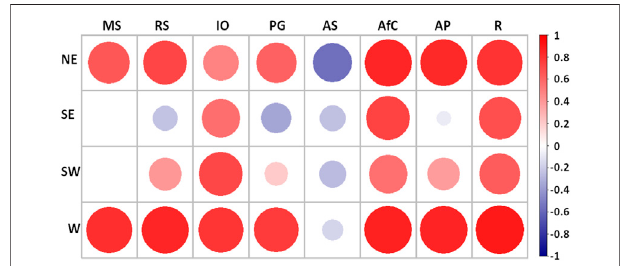
FIGURE 7 | Pearson correlation values obtained between the series of precipitation over the NE, SE, SW, and W regions from the Climatic Research Unit and the |(E − P) < 0| computed over these regions on air masses tracked forward in time from all the sources (MS, RS; IO; PG; AS; AfC, AP, and